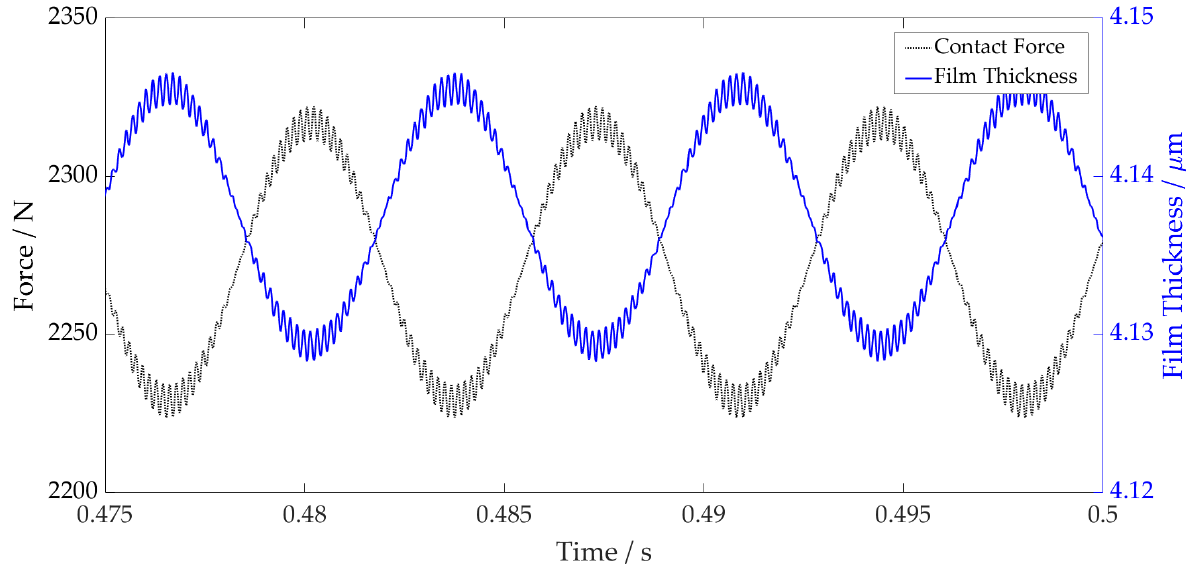
Figure 13. Film Thickness vs. Contact Force 21,000 rpm.